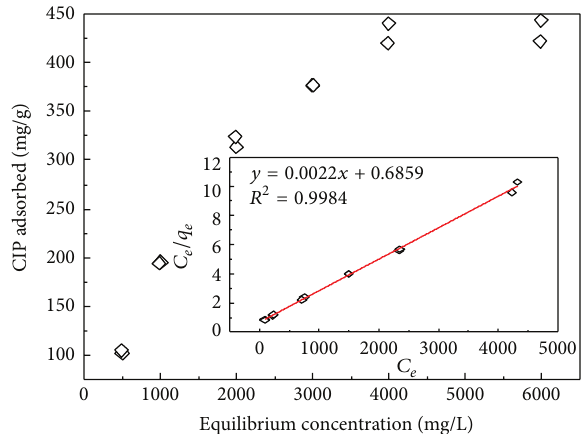
Figure 5: CIP adsorption on birnessite (V). The solid line is the Langmuir fits to the observed data.